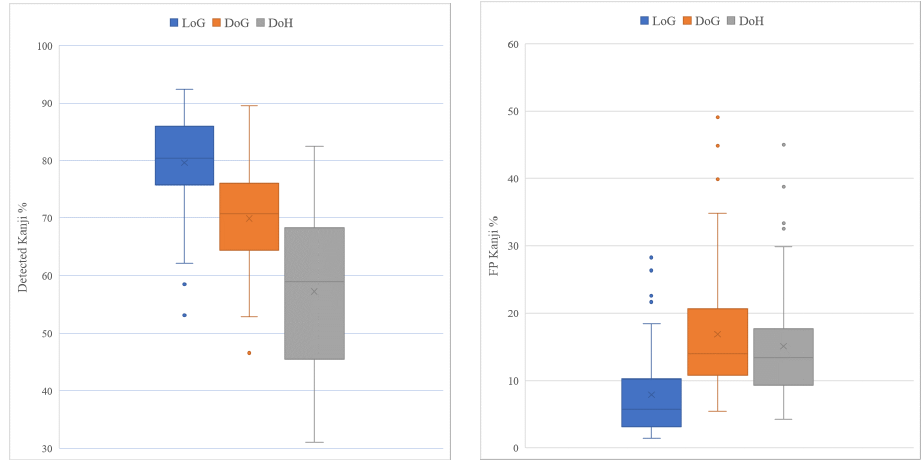
Figure 8. Comparison of the performance of blob detector algorithms for kanji detection.( left , correctly detected kanji %, right , false positive detection